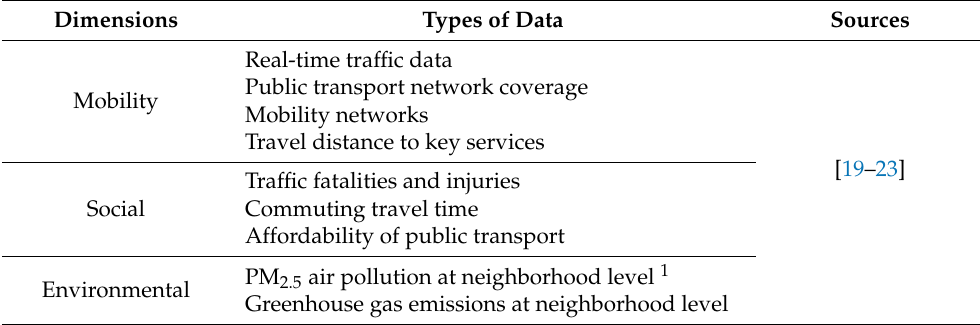
Table 1. Nine types of mobility data relevant for use in GIS